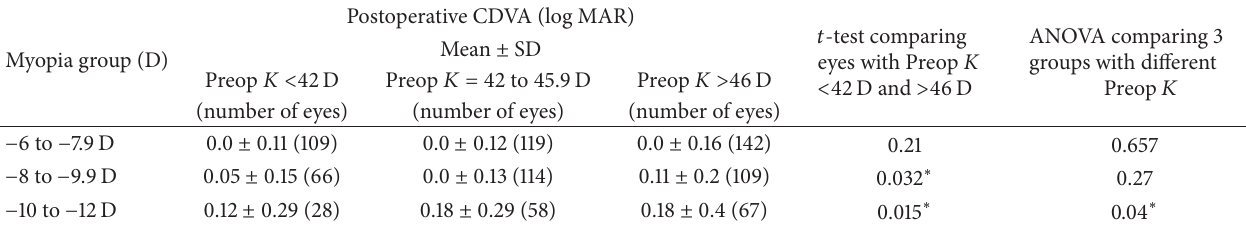
Table 2: Postoperative CDVA stratified by preoperative